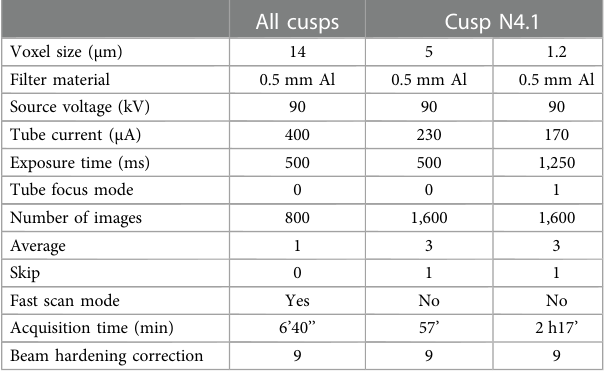
TABLE 2 Microct acquisition and reconstruction parameters, cusp N4.1 corresponds to the NF-LG-SAS cusp that was imaged at two higher resolutions after the selection of a region of